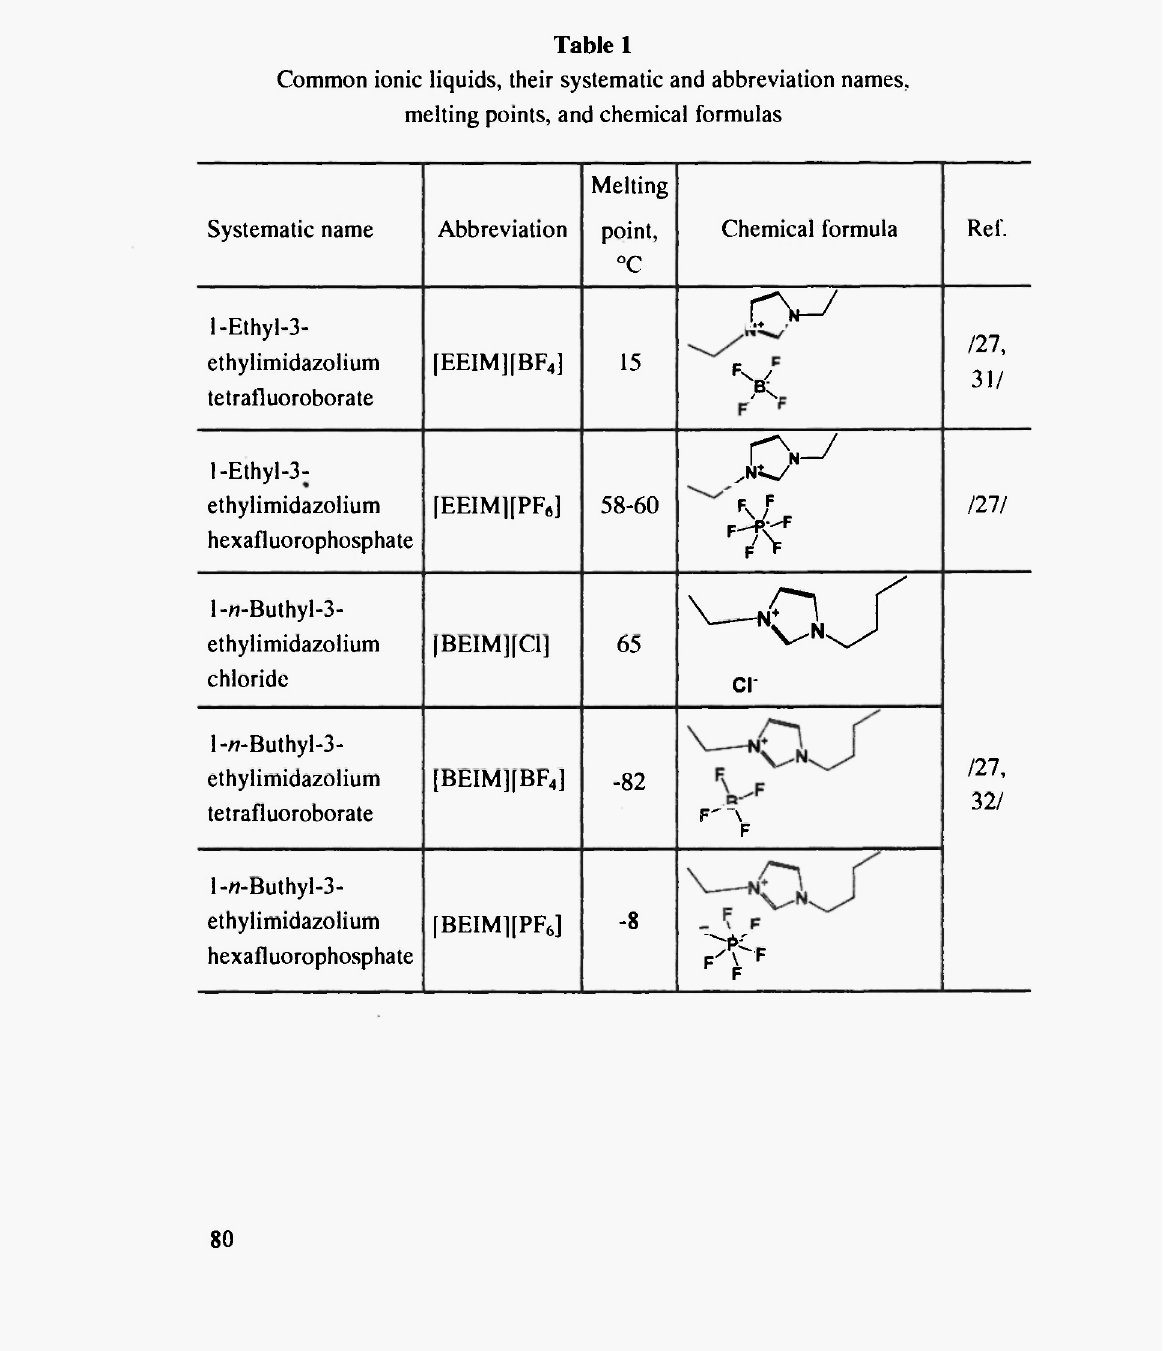
Common ionic liquids, their systematic and abbreviation